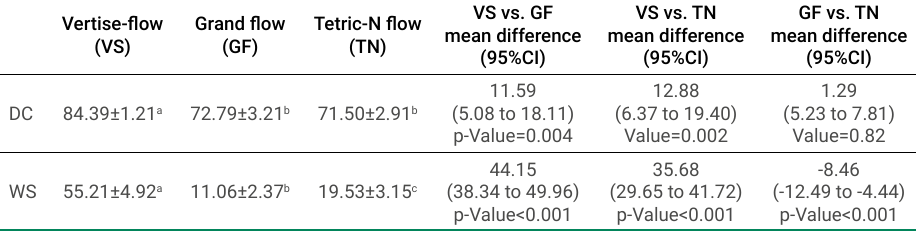
Means with the same superscript letters indicate non-significant difference